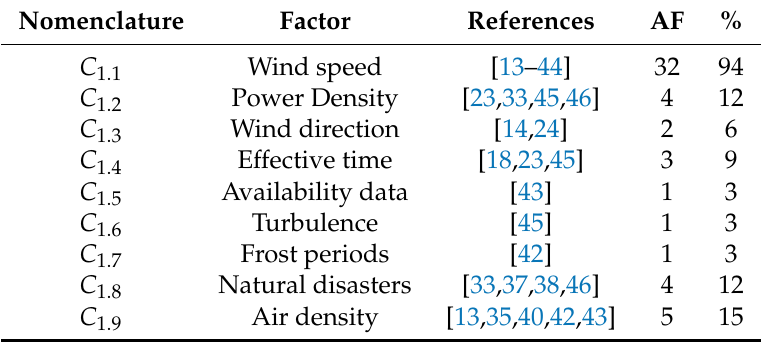
Table 7. Climate Category ( C 1 )—Onshore optimal location. Quantitative analysis.